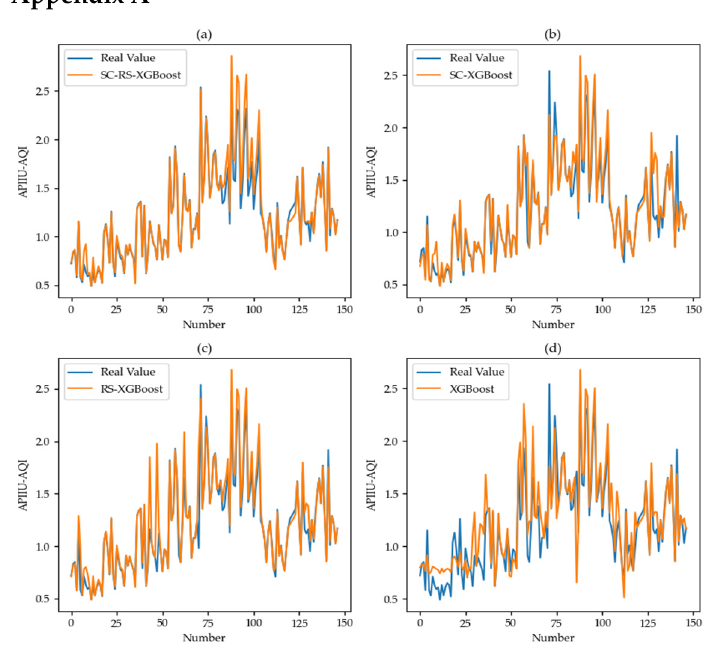
Figure A1. Comparison of real values and predicted values of APIIU-AQI from ( a ) SC-RS-GBoost